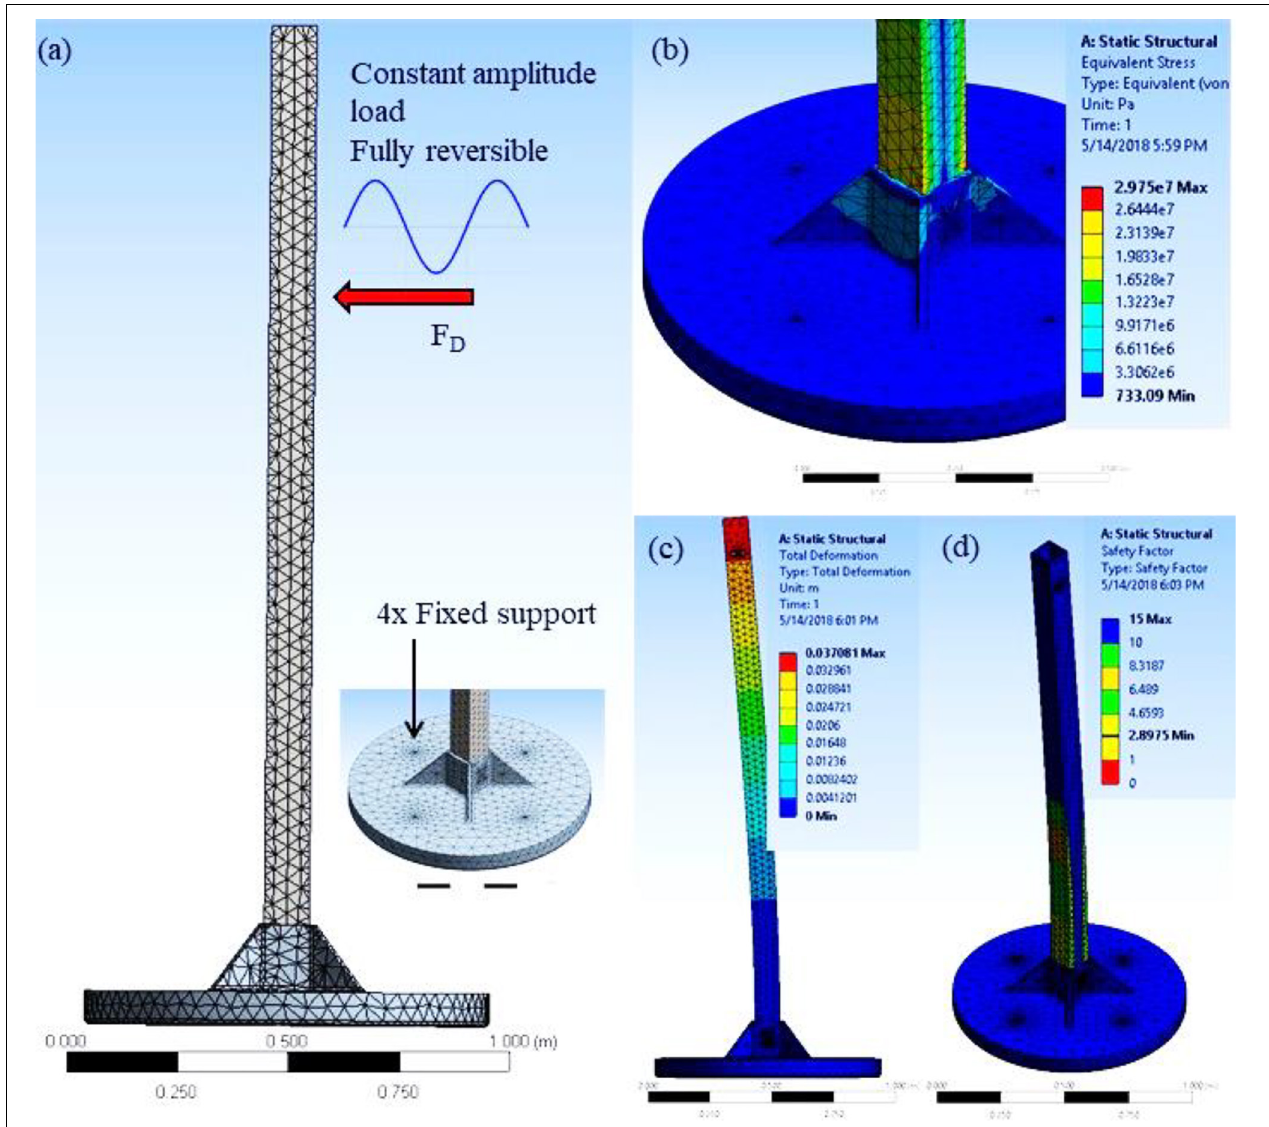
FIGURE 2 | Finite element model of a single leg subject to horizontal drag force: (a) the generated mesh, (b) the maximum equivalent von-Mises stress, (c) total deformation, and (d) the factor of safety for extreme case of 1,815 N of drag force.